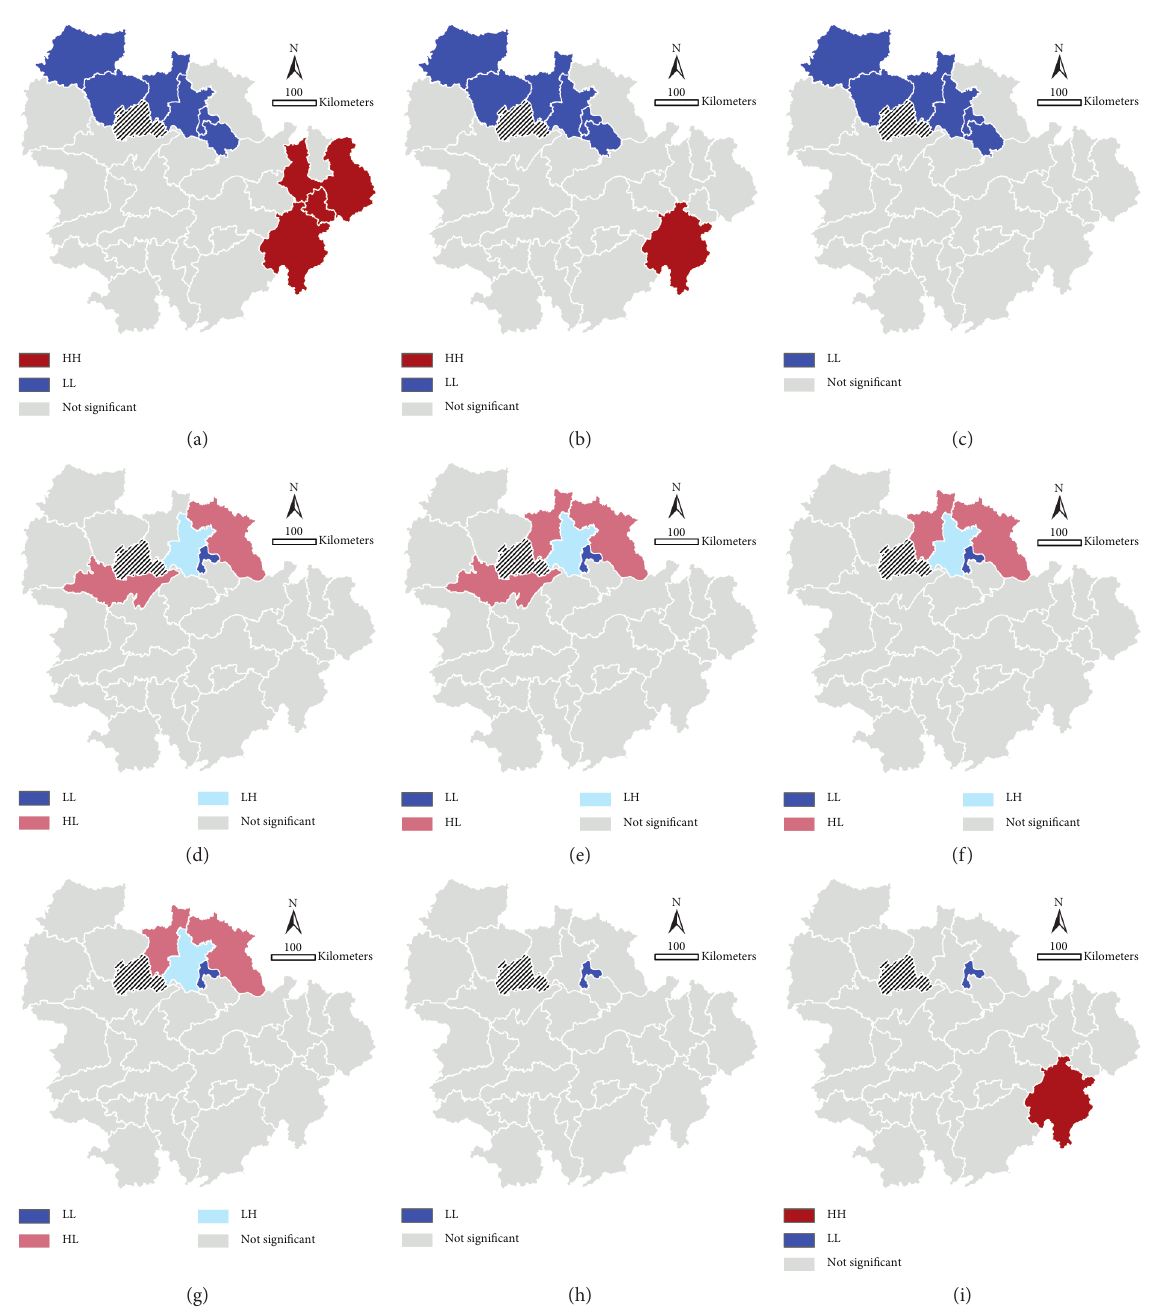
Figure 4: LISA clustering distribution of the in-city travel intensity recovery index by time periods (weeks 1–9): (a) Y 3 week 1; (b) Y 3 week